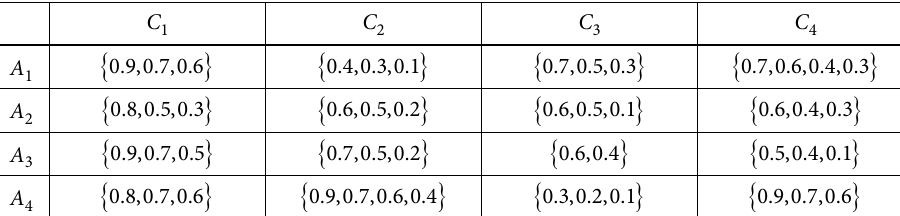
Table 4. Hesitant fuzzy decision matrix of expert e